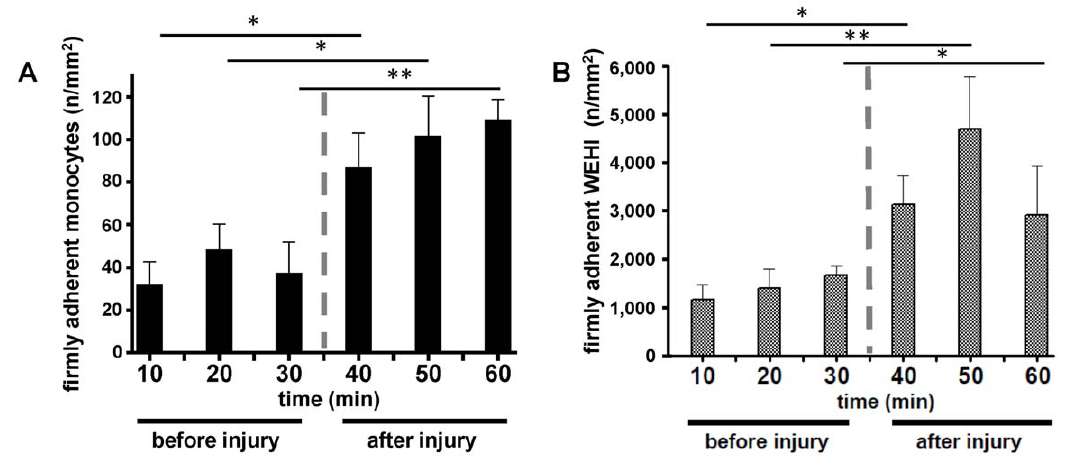
Figure 5. Monocyte and WEHI 274.1 recruitment to intact and injured atherosclerotic carotid artery lesions. ( A ) Monocyte adhesion to atherosclerotic endothelium (indicated ‘before injury’) and to the injured atherosclerotic vascular wall (indicated ‘after injury’) in ApoE 2 / 2 mice ( B ) WEHI 274.1 adhesion to inflamed atherosclerotic endothelium and to the injured atherosclerotic vascular wall in ApoE 2 / 2 mice. Adhesion of monocytes and WEHI 274.1 was significantly increased following injury. n=4–8, *p , 0.05, **p ,